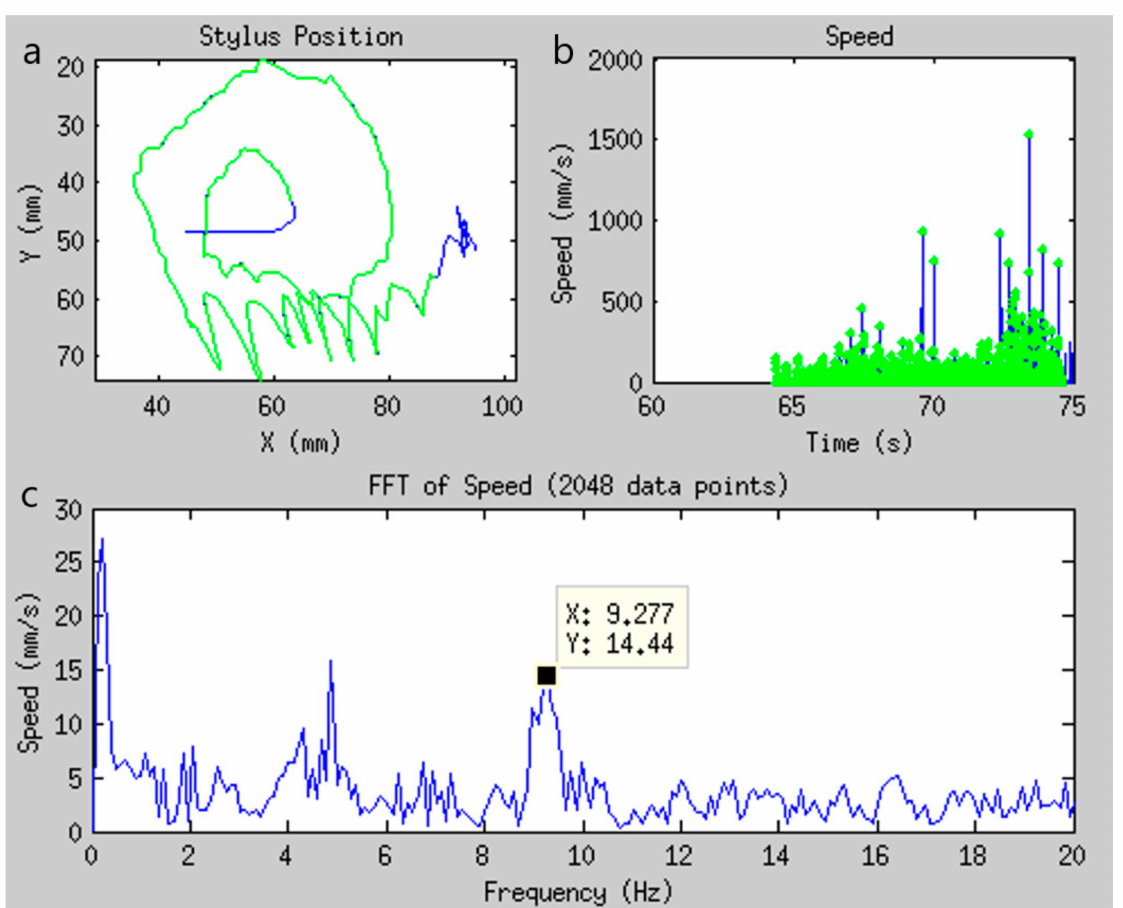
Figure 8. Tablet drawing signal analysis showing pre-treatment data for a patient with essential tremor. ( a ) Stylus position ink marks. Blue ink indicates raw cursor data, green indicates resampled cursor data which can be compared with the drawing screenshot (not shown); ( b ) Stylus speed over time (blue) with selected data points (green). Stylus speed was calculated by taking the derivative of stylus position; ( c ) The fast Fourier transform (FFT) of the selected speed data. Frequency peaks were selected for tremor evaluation. Taken from [76]. Copyright © 2017 Tam et